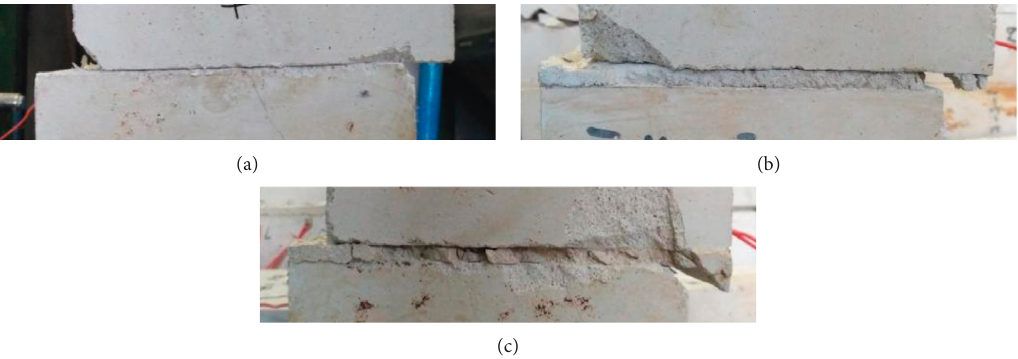
Figure 10: Failure modes of different joints. (a) Nonfilled joint. (b) Failure mode 1 of the bolted grouted joint. (c) Failure mode 2 of the bolted grouted